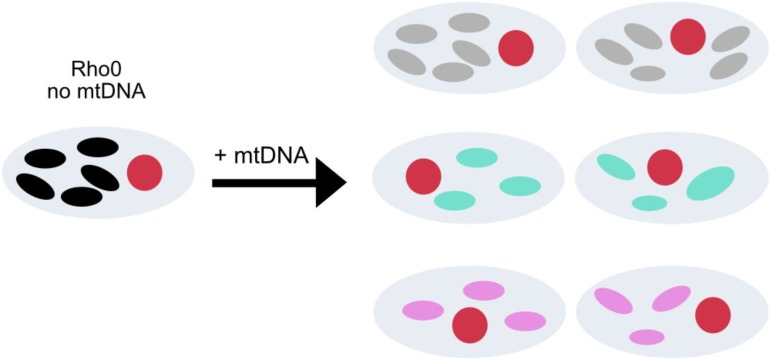
Transmitochondrial cybrid model. Construction of cybrid cell lines containing the same nuclear DNA, but mtDNA from healthy individuals with different mtDNA haplogroups. The oval circles inside the cell with colors white, gray, blue, pink and black represent no mtDNA and mtDNA from with different mtDNA, respectively.